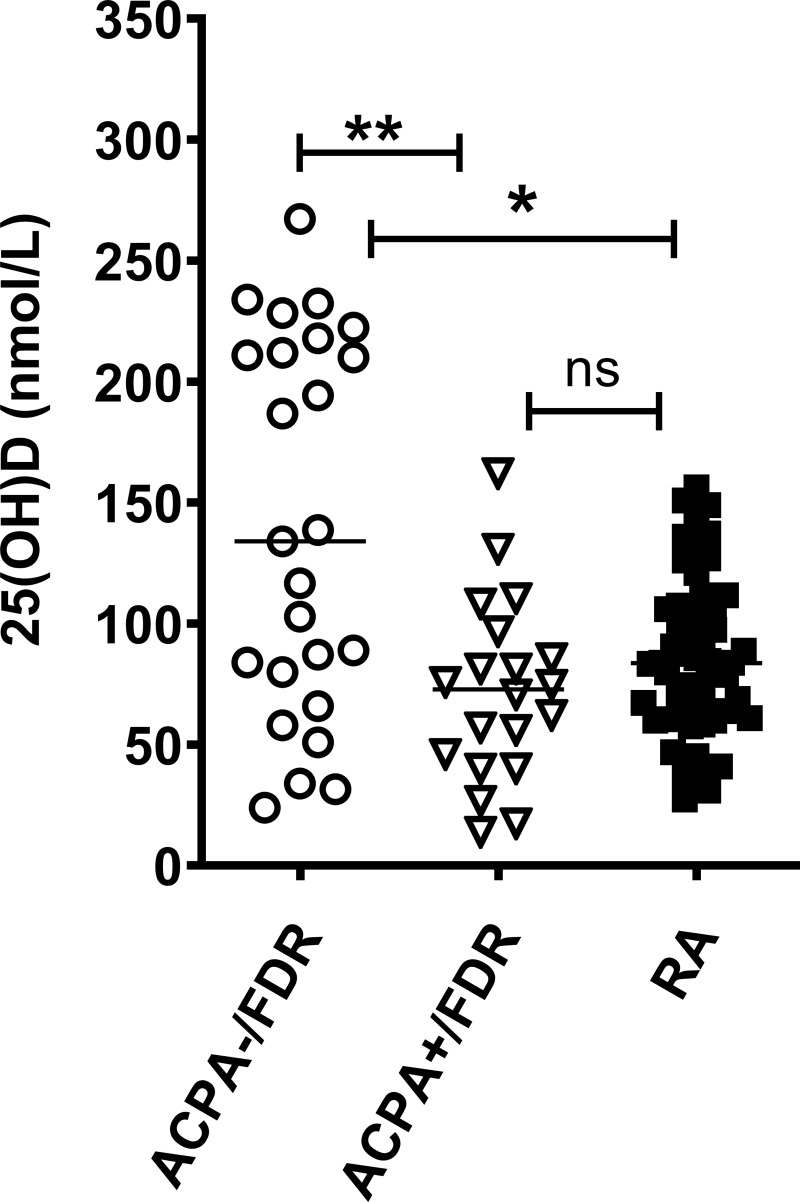
Cross-sectional analysis of 25(OH)D levels in ACPA-/FDR, ACPA+/FDR and RA patients–Scatter plot showing the distribution of 25(OH)D levels after correcting for storage and seasonal effect.Data was analyzed by Kruskal-Wallis test with Dunn’s post-hoc test (**P<0.01, *P<0.05).